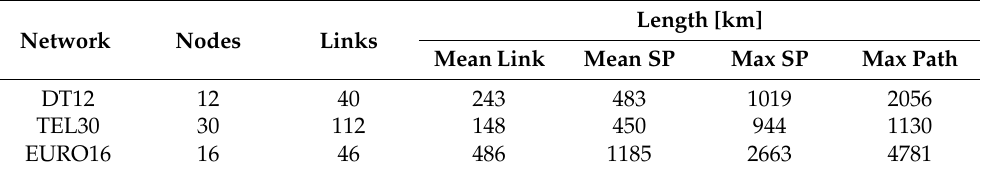
Figure 2. Network topologies: DT12, TEL30, and EURO16. Table 2. Characteristics of network topologies; SP means shortest path.